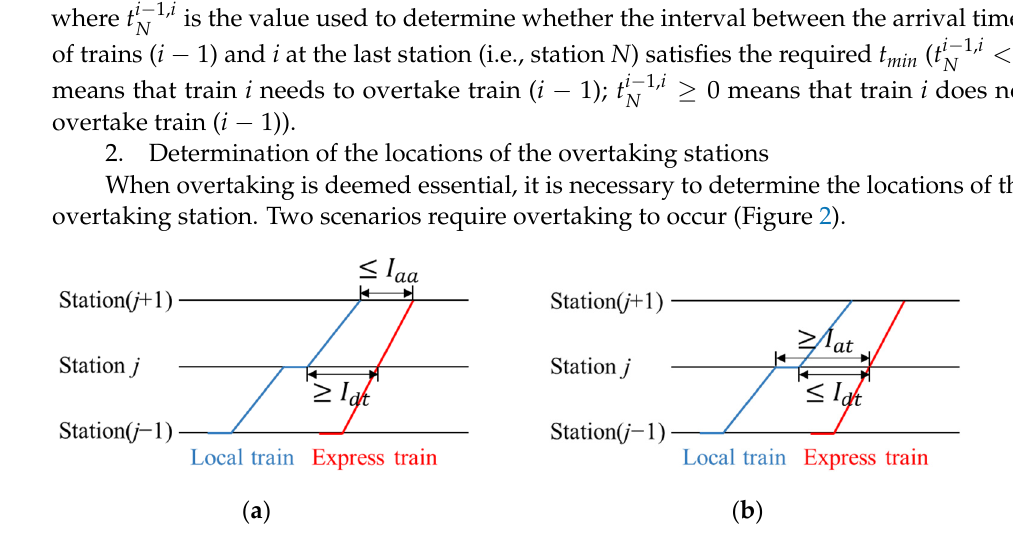
Figure 2. Two scenarios where the express train overtakes the local train: ( a ) Scenario 1; ( b ) Scenario 2.